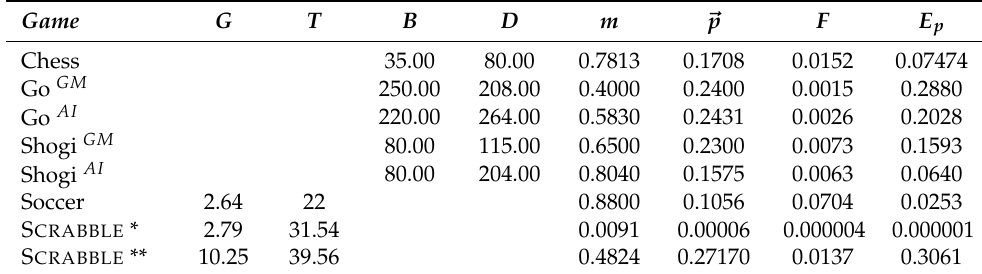
Table 4. Comparison of various physics-in-mind measures of several games (adopted from [64,65]), including